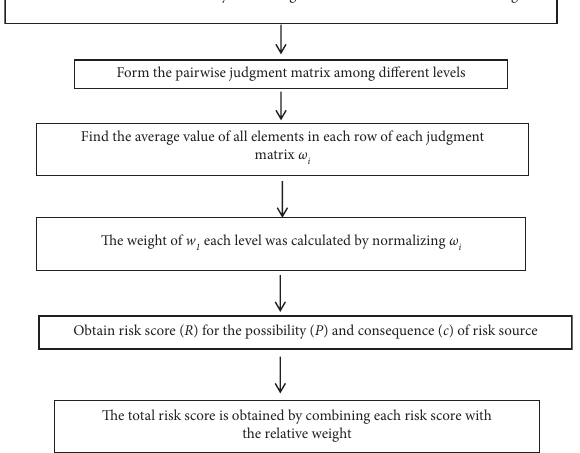
Figure 3: Flow chart of expert scoring and AHP comprehensive evaluation